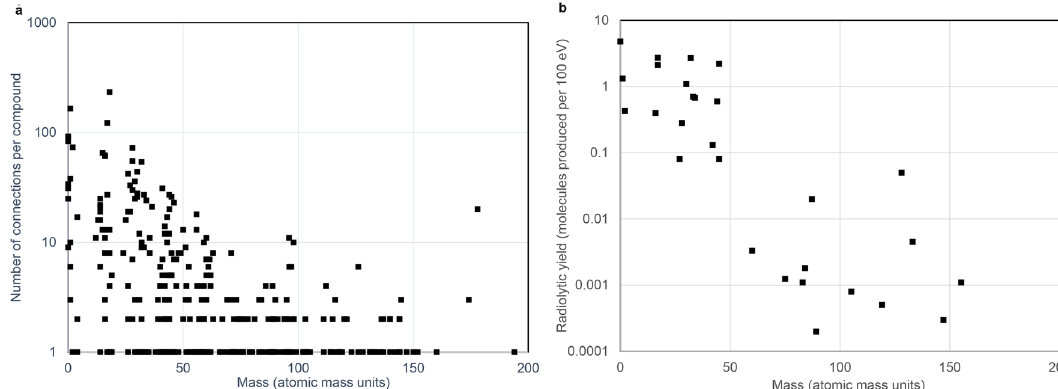
Figure 3. Indicators of hierarchical stratification in small molecule radiolytic chemical systems. ( a ) Connectivity degree per compound in the assembled radiolysis network, plotted versus chemical species mass. ( b ) Experimentally obtained radiolytic abundance ( G values), plotted versus chemical species mass. Most plotted values are based on radiolysis of aqueous HCN/ - CN. The plotted G value for hydrogen cyanide